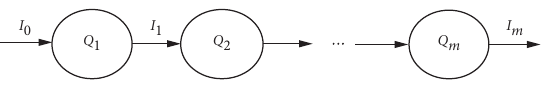
Figure 2: Neuron model of tourist route.